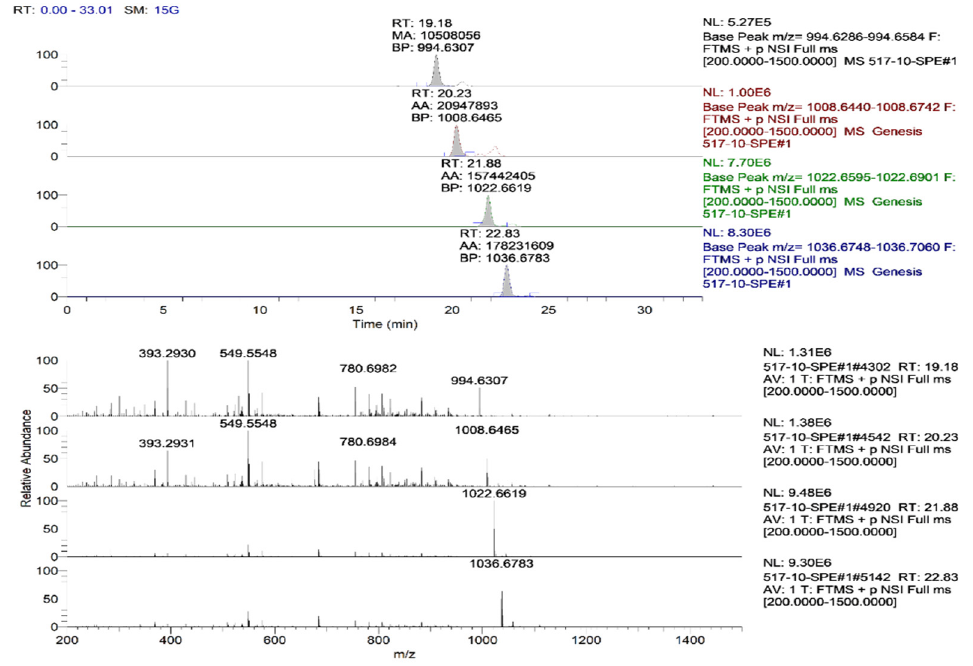
Figure 12. HPLC-ESI+-HRMS spectra of Surfactin A-CH 2 , Surfactin A, Surfactin B, and Surfactin C for sample BZR 517.